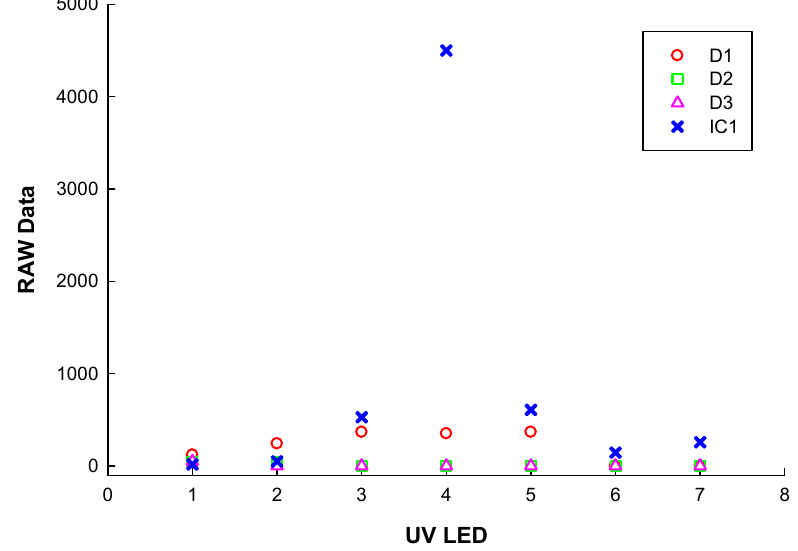
Table 4. Evaluated irradiance on the sensors using the UV LEDs from the calibrator circuit. LED #